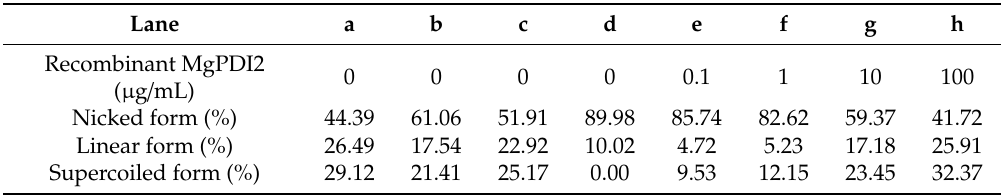
Figure 4. Biological activity of recombinant MgPDI2. ( A ) Dithiothreitol (DTT)-mediated insulin reduction by recombinant MgPDI2. ( B ) Potential of recombinant MgPDI2 to protect super-coiled DNA from cleavage in a mixed-function oxidase (MFO) system. Lanes: a, pGEM-T without any treatment; b, pGEM-T incubated with 1.65 mM DTT; c, pGEM-T incubated with 16.5 mM FeCl3; d, pGEM-T incubated with the MFO system; e–h, pGEM-T incubated with the MFO system and di ff erent concentrations (0.1, 1, 10, and 100 µ g / mL, respectively) of purified MgPDI2. The nicked, linear, and super-coiled forms of pGEM-T are shown from the top to the bottom. Numerical values are reported in Table 1.